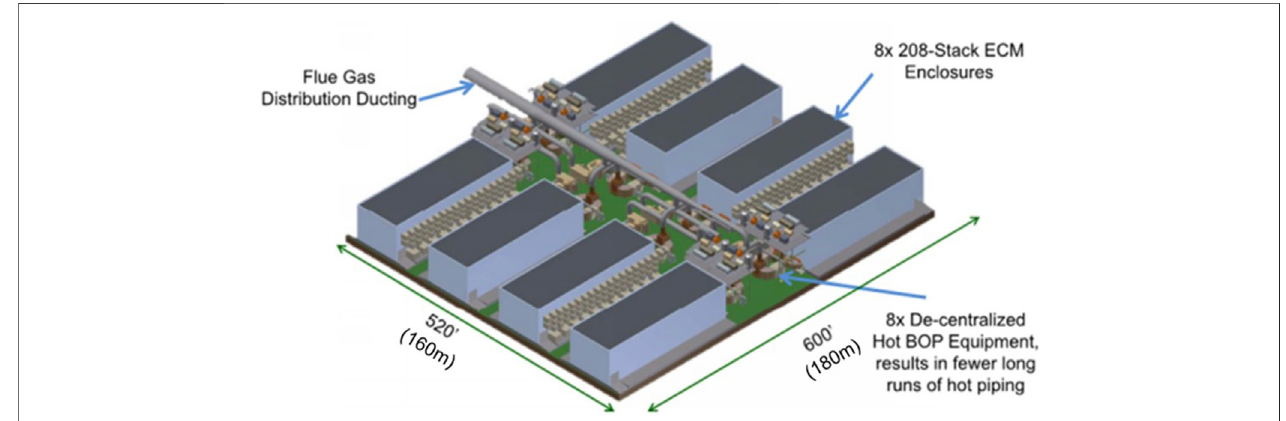
FIGURE 2 | Sketch of a 350 MWe MCFC Installation (Image courtesy of FuelCell Energy Inc. based upon work supported by the US Department of Energy under Award Number DE-FE0026580).